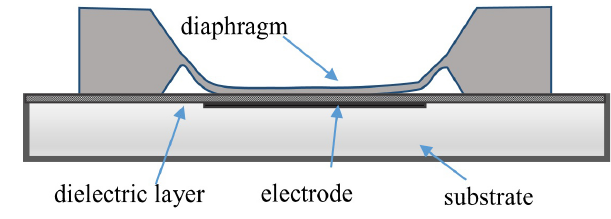
Figure 5. A touch mode capacitive pressure sensor (Gad-el-Hak,